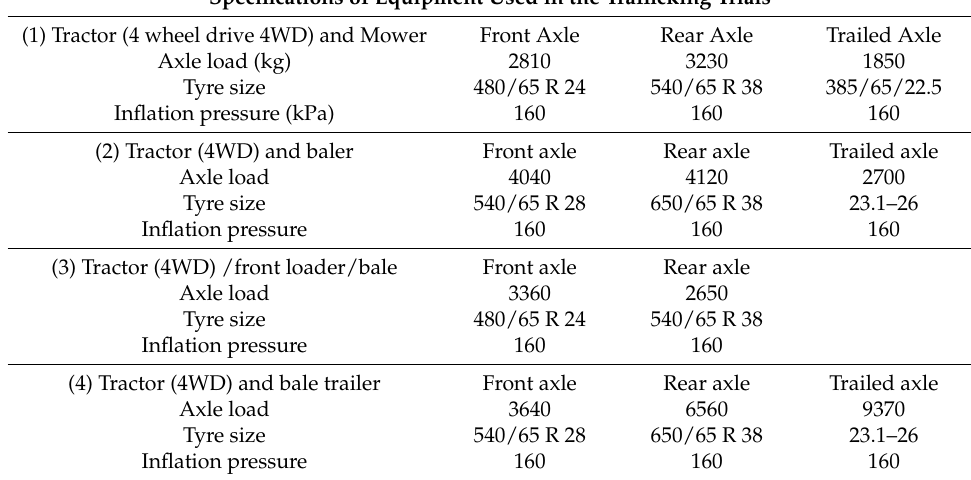
Table 2. Axle loads (kg), tyre sizes and tyre inflation pressures (kPa) of the components used to simulate baler system traffic in Miscanthus harvesting.